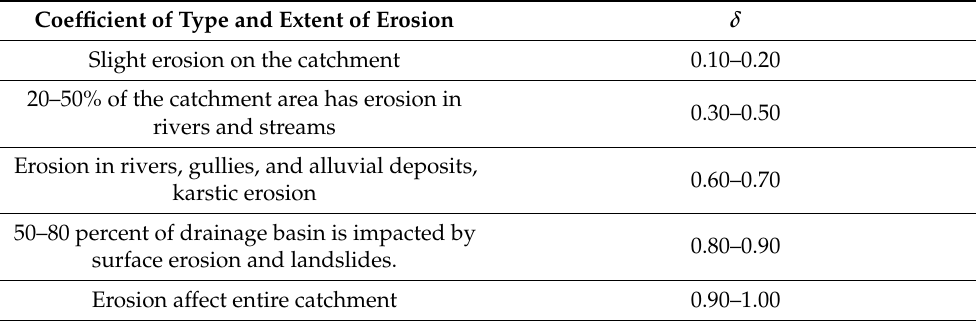
Table 4. EPM coefficient values of erosion coefficient.